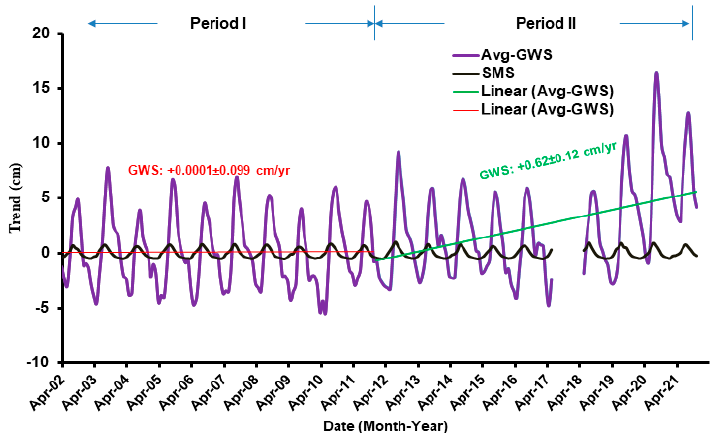
Figure 11. The Monthly ∆ GWS and ∆ SMS time series for the research region during the two periods.